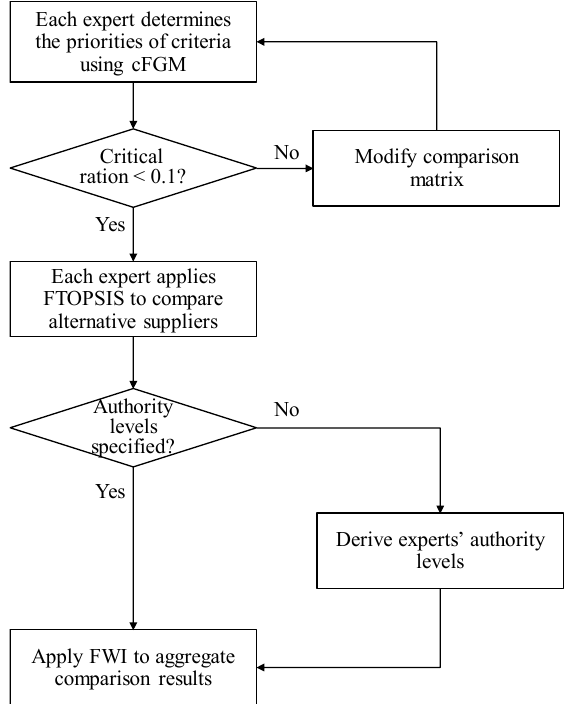
Figure 2. The steps of the proposed methodology.